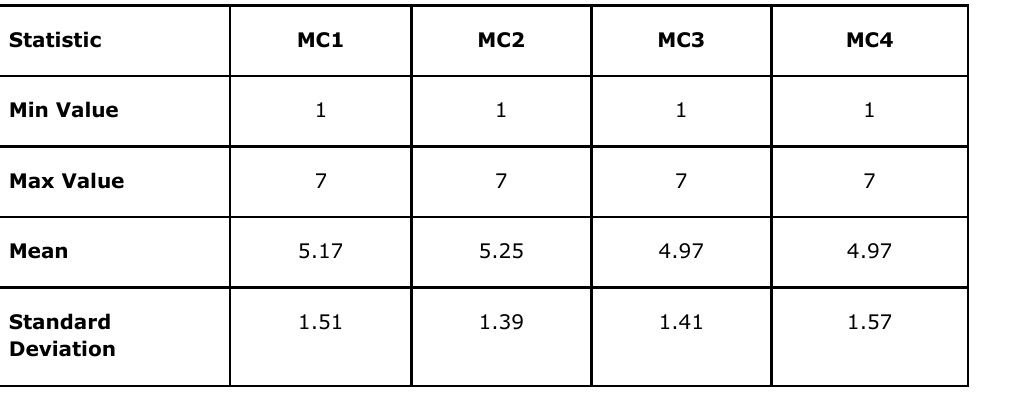
CQ Strategy Range, Means, and Standard